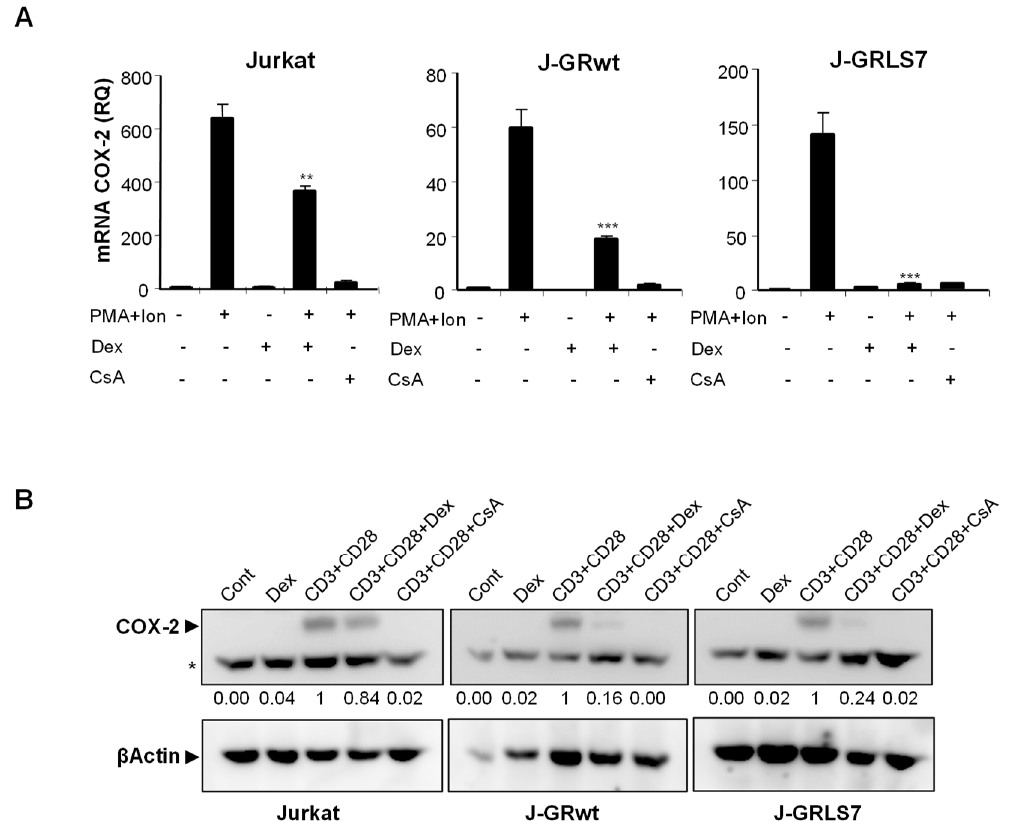
Figure 2. Effect of Dex on COX-2, IL2, and TNF α expression in activated Jurkat cells. ( A ) Analysis of COX-2 mRNA levels by quantitative real-time RT-PCR in Parental, J-GRwt, and J-GRLS7 Jurkat cells treated with PMA + Ion (15 ng/mL + 1 µ M) or with anti-CD3/CD28 Abs (5 µ g/mL; 1 µ g/mL) for 18 h in the presence or absence of Dex (1 µ M) or CsA (100 ng/mL). Results shown are from a representative of two independent experiments performed in triplicate and are expressed as RQ ± SEM (** p < 0.01; *** p < 0.001; vs. PMA + Ion treatment). ( B ) COX-2 protein levels were analyzed by Western blot in cell extracts. Nonspecific bands (marked by an asterisk) are also shown as internal loading control. Normalized relative densitometric quantification of COX-2 bands with respect to β Actin loading control are shown below each lane.